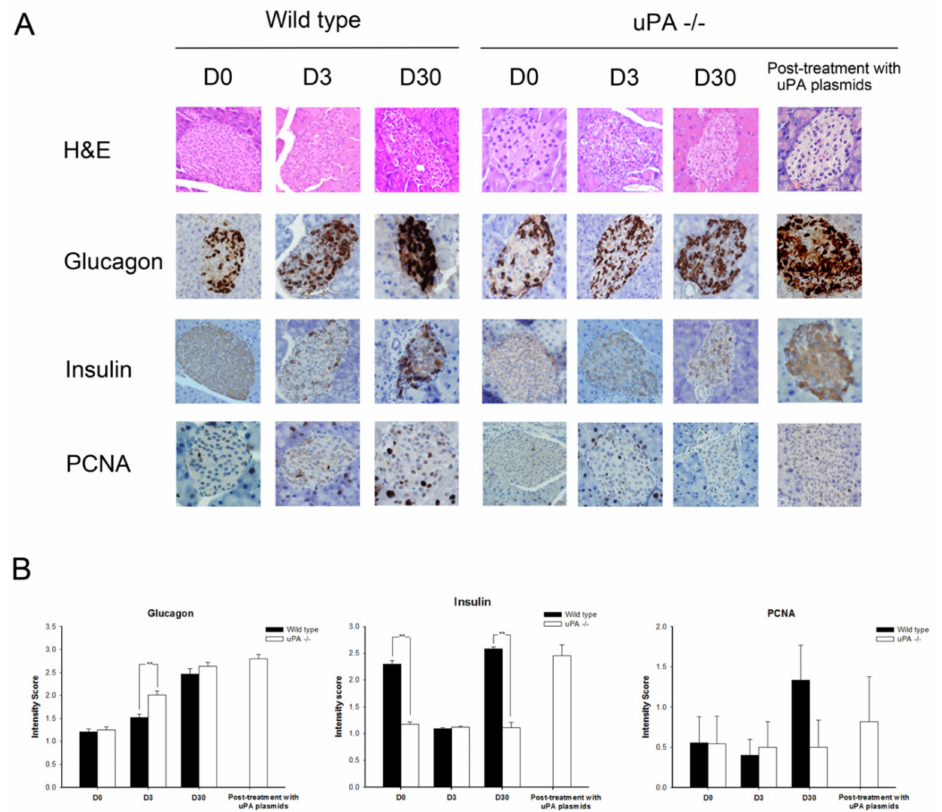
Figure 2. Hematoxylin and eosin (H&E), and immunohistochemical (IHC) stain of glucagon, insulin, and proliferating cell nuclear antigen (PCNA) on islet before and after induction of type 2 diabetes mellitus in wild-type and uPA- / - mice and after treatment with uPA plasmids in uPA- / - mice. ( A ) The H&E stain of islet showed no pathologic structural change in either wild-type or uPA- / - mice. The expression of glucagon on islet increased after induction both in wild-type and uPA- / - mice. Obviously, insulin particles of islet 30 days after induction (D30) increased in wild-type mice as compared with uPA- / - mice. Meanwhile, the PCNA expression of islet increased on D30 in wild-type mice. After treatment with uPA plasmids in uPA- / - mice, the glucagon, insulin, and PCNA expressions are similar to those on D30 in wild-type mice. ( B ) The quantitative intensity score of expression of glucagon, insulin, and PCNA on islets on induction day (D0), D3, and D30, after induction was assessed and scored by pathologists. The intensity scores of glucagon in uPA- / - mice were significantly higher than those in wild-type mice on D3. The intensity scores of insulin in wild-type mice were significantly higher than those in uPA- / - mice on D3 and D30. The intensity score of PCNA in wild-type mice on D30 was higher, but did not reach statistical significance. ** p < 0.01 (Kruskal–Wallis H